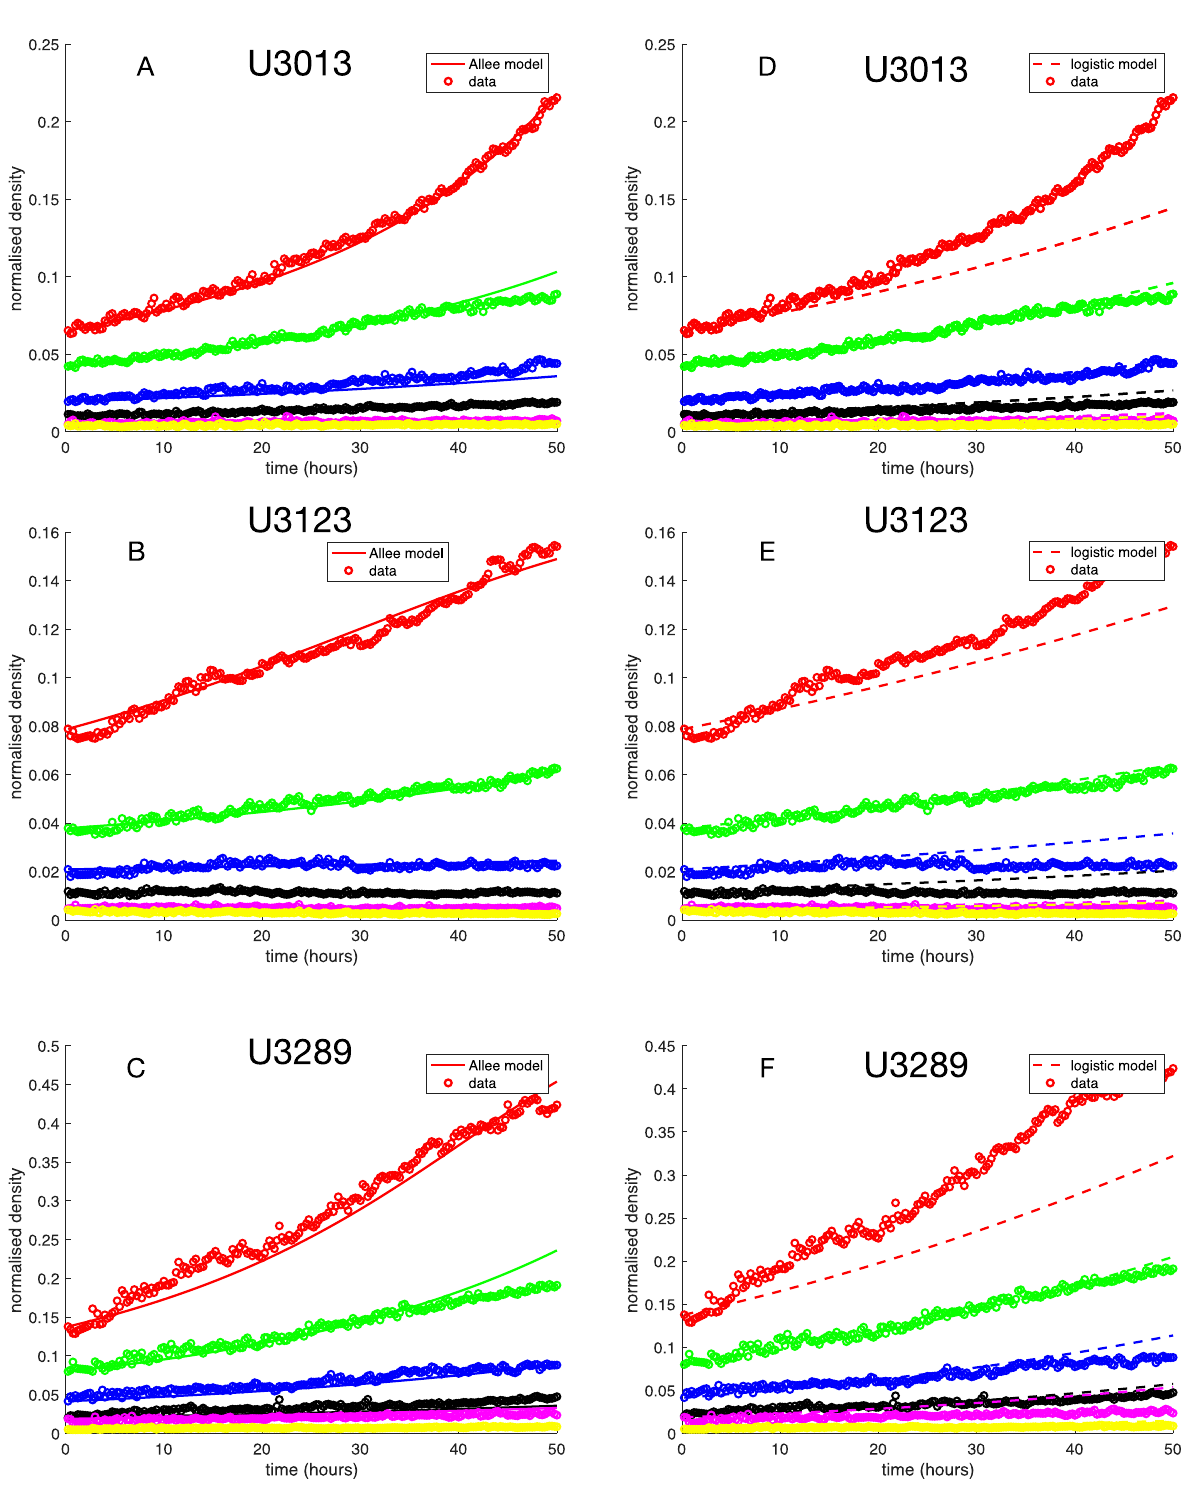
Fig 5. Least squares fit of the Allee ODE-models to in vitro growth of the glioblastoma cell lines U3013MG, U3123MG and U3289MG. Panels A-C show the best fit of the Allee model whereas D-F show the best fit for a logistic growth model (where ρ = 0). Visual inspection suggests that the Allee model outperforms the logistic model. This was confirmed using Akaike Information Criterion (see Table 2).